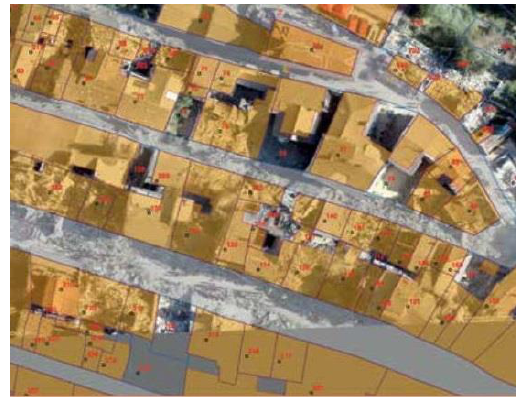
Figure 1. Example of cadastral data overlapping satellite